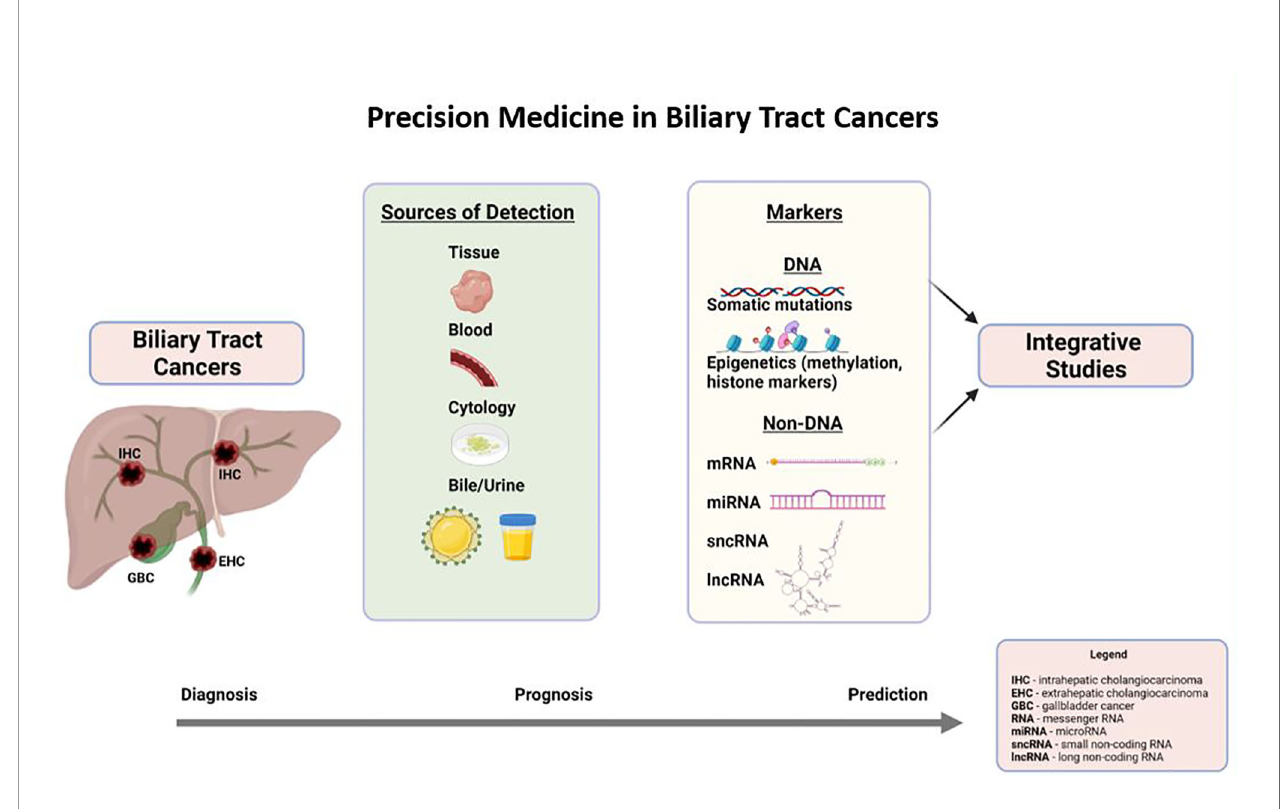
FIGURE 1 | Precision medicine in biliary tract